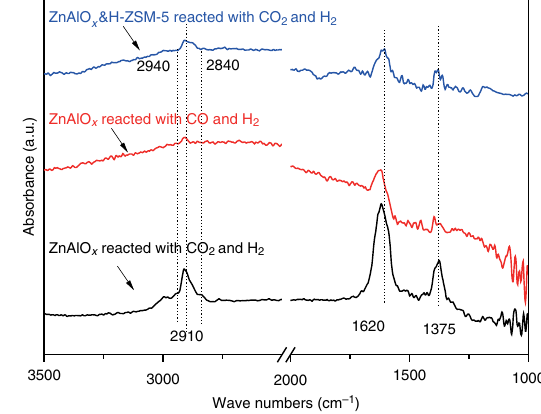
Fig. 5 Operando DRIFT spectra over various catalysts. Conditions: 593 K, 0.1 MPa. CO 2 &H 2 refers to the mixed gas of H 2 /CO 2 /Ar = 3/1/0.2; CO&H 2 refers to the mixed gas of H 2 /CO/Ar =